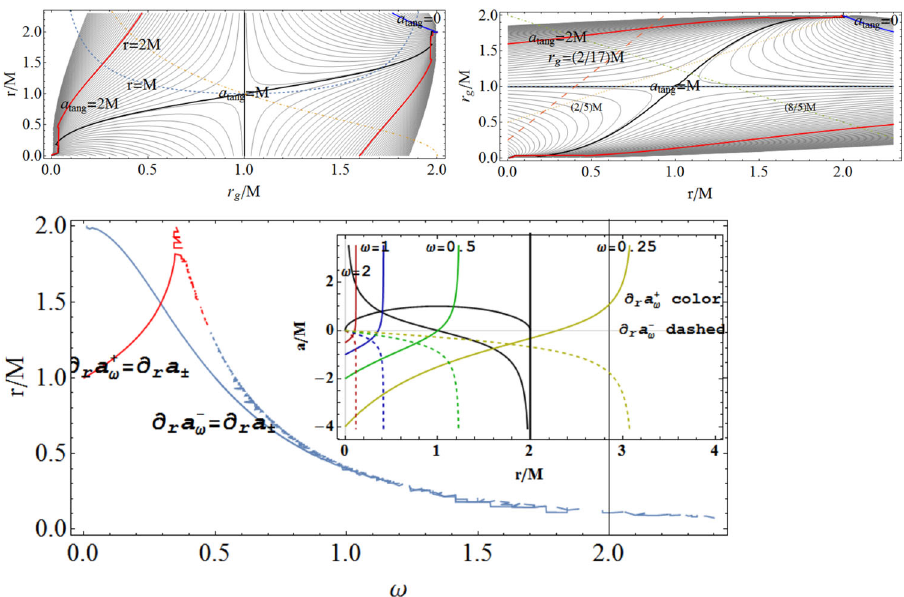
Fig. 16 Below panel: solutions ∂ r a ± ω = ∂ r a ± in the plane r / M − ω . Bundles frequencies and the contact point to the horizons are repre- sented for ω = 0 . 5. The CC model of Fig. 15 and Table 3, where r g = M and a g = M . Inside panel: The black curve is the horizon a ± and the function ∂ r a ± ; there are the two vertical asymptotes for the point ( a = 0 , r = 0 ) and (a=0,r=2M) corresponding to the limit- ing static geometry. Models XX are shown with bundle frequencies for the evaluation of (∂ r a ± ω ( X )) , where X = { A , B , C , D } is considered in